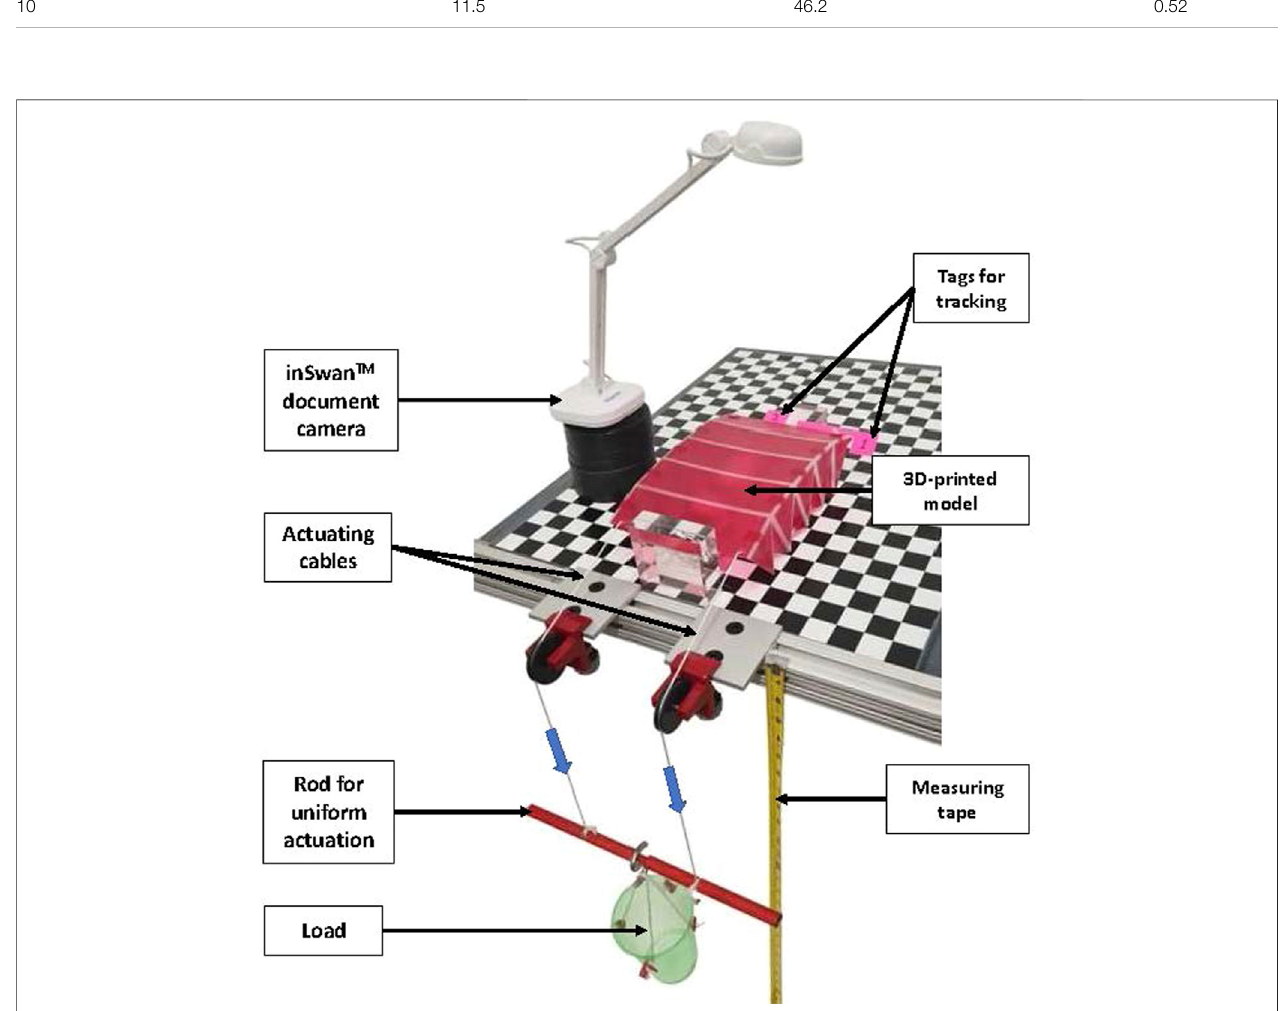
FIGURE 7 | Setup for the experimental study of OPB structure. Actuation cables on either side of the 3D-printed model go over the pulleys and connect to a rod. The structure is uniformly actuated pseudo-statically by applying load on the rod. The inSwan TM document camera is used to capture the displacement of the experimental model and contrasting tags are used for tracking these displacements using computer vision.